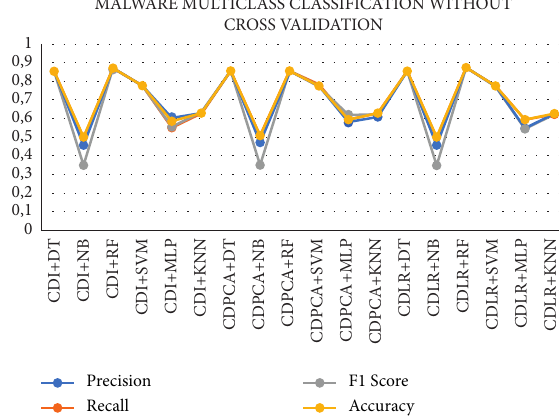
Figure 6: Experimental result of malware multiclass classification without